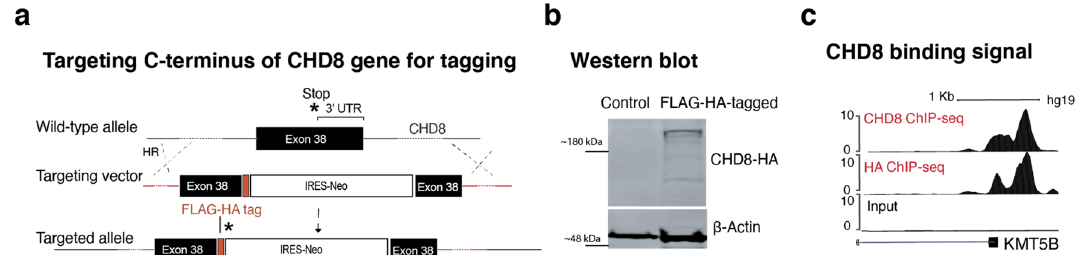
Figure 8. ChIP-seq of endogenously tagged CHD8 in stem cells revealed binding to its previously described target promoters. ( a ) Targeting strategy to insert a C-terminal FLAG-HA tag at the endogenous CHD8 locus (see Fig. 3a–d). ( b ) Western blot analysis of tagged and non-tagged (control) ES cells using an anti-HA antibody (see the full-length version of this blot in Fig. 9e). ( c ) A CHD8 peak at promoter of the KMT5B gene.